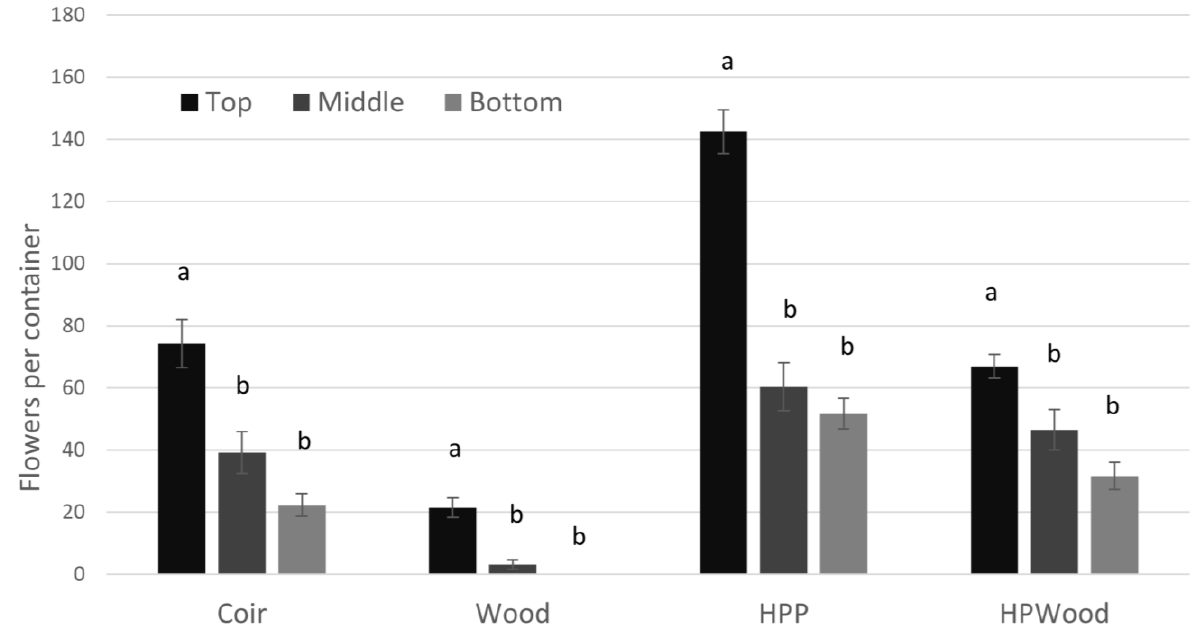
Figure 7. Number of flowers per container in different substrates and levels in plant towers. Vertical bars represent ± SE (n = 6). Different lowercase letters indicate statistically significant differences between the levels within each substrate ( p < 0.05) by Tukey’s